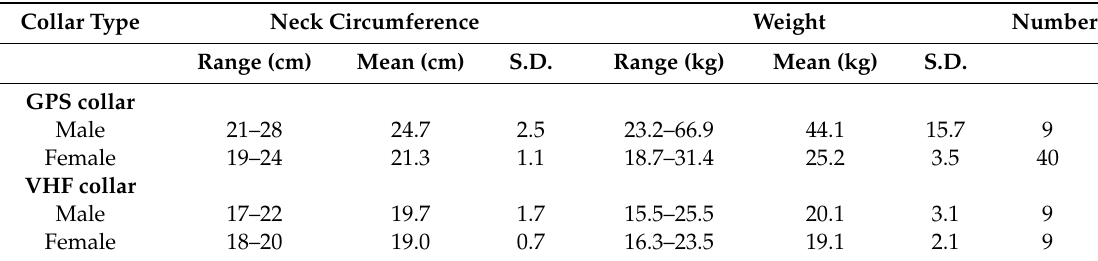
Table 2. Number and size characteristics of GPS and VHF collared western grey kangaroos (S.D. = standard